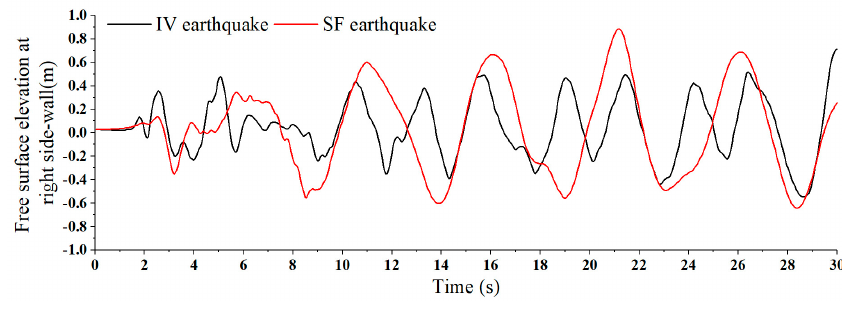
Figure 12. Free surface elevations at right side wall.